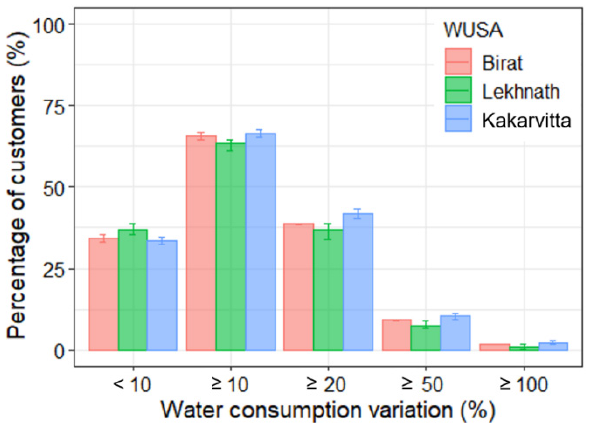
Figure 5. Proportion of customers with water consumption variation.